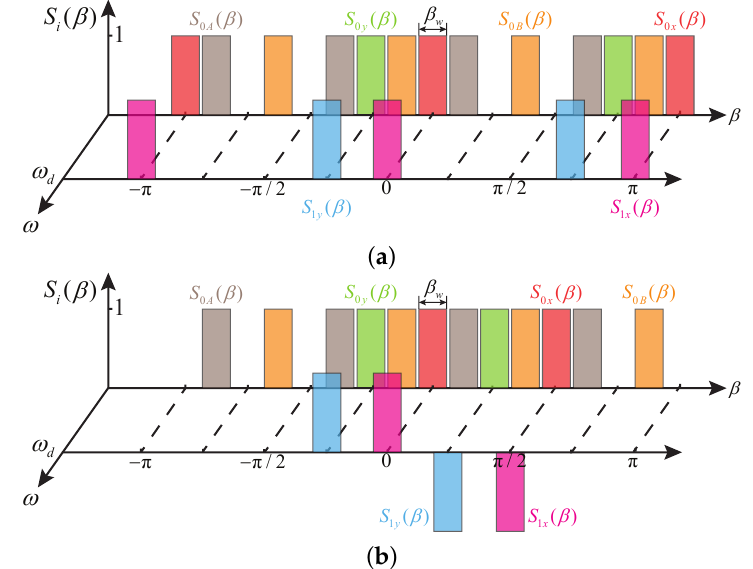
Figure 8. Force distribution functions of MHRs. ( a ) S i ( β ) for the single-ended electrode arrangement. ( b ) S i ( β ) for the differential electrode arrangement.